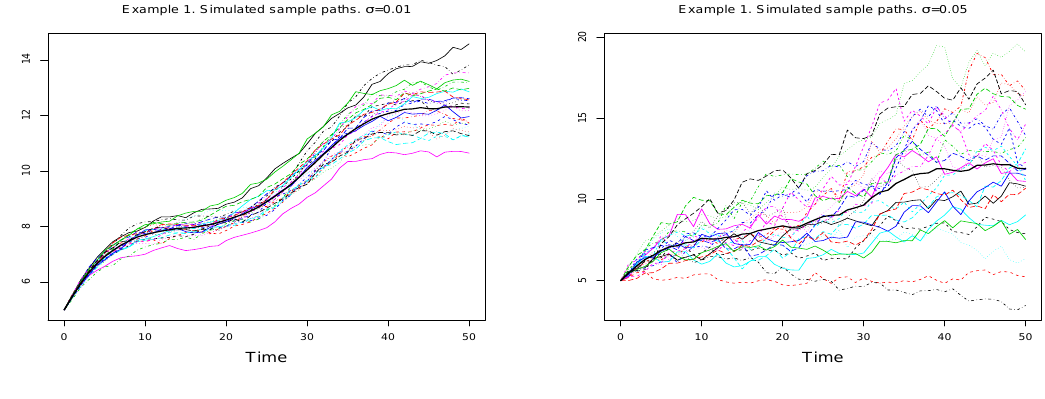
Figure 2. Example 1. Simulated sample-paths. Black lines represent the sample